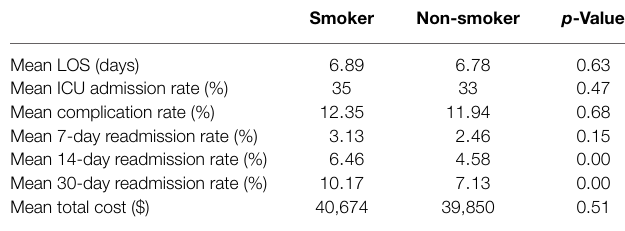
TABLE 4 | Outcomes of patients admitted for spinal treatment for curvature .